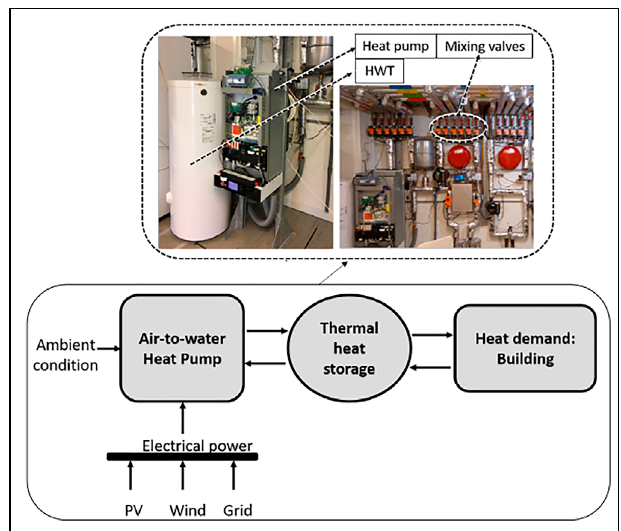
FIGURE 2 | Experimental system layout of a residential HP